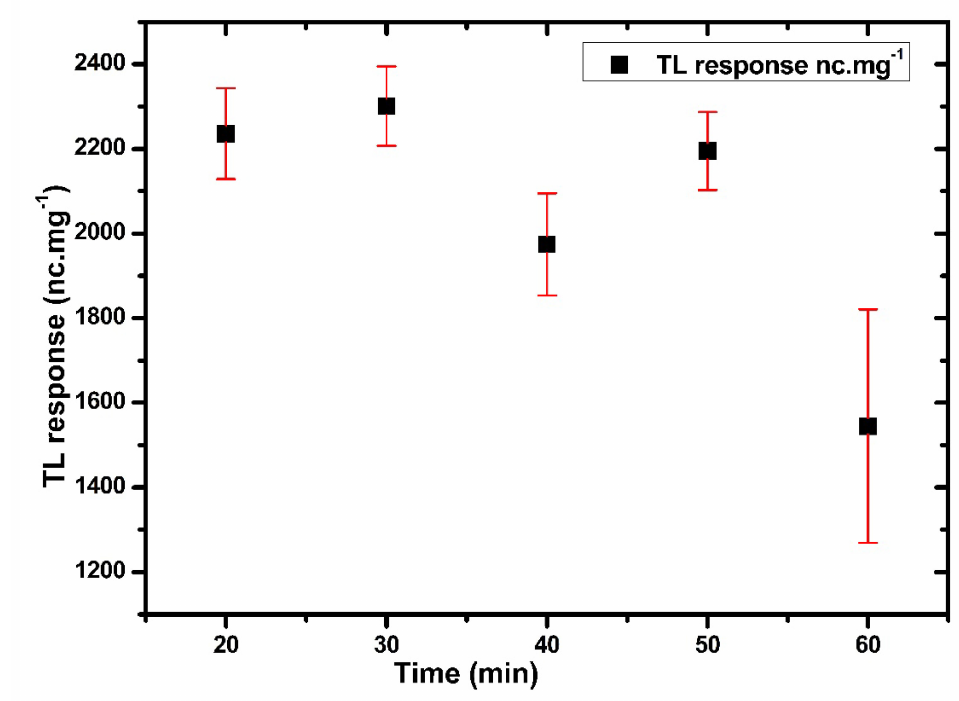
Figure 12. The TL response of Ag-doped ZnO thin films with different annealing